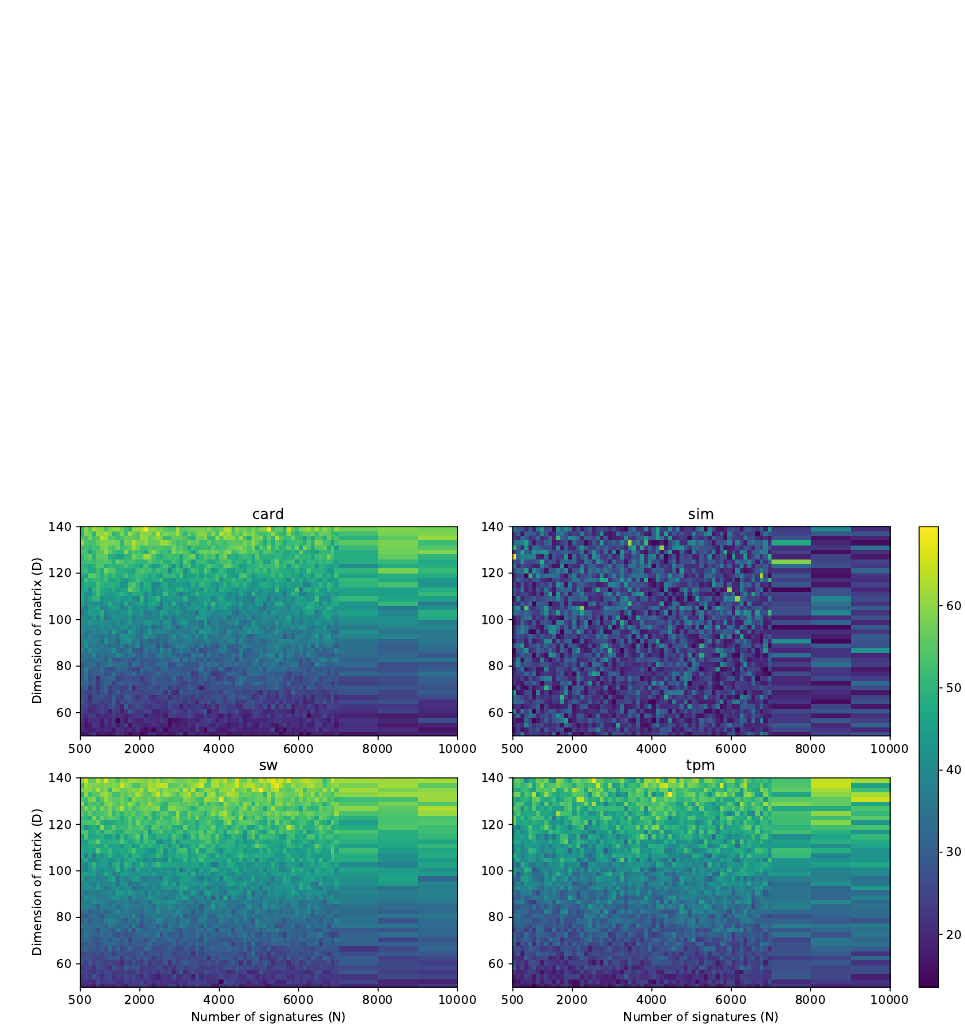
Figure 17: Heatmap of average number of errors for the various datasets, when using geometric